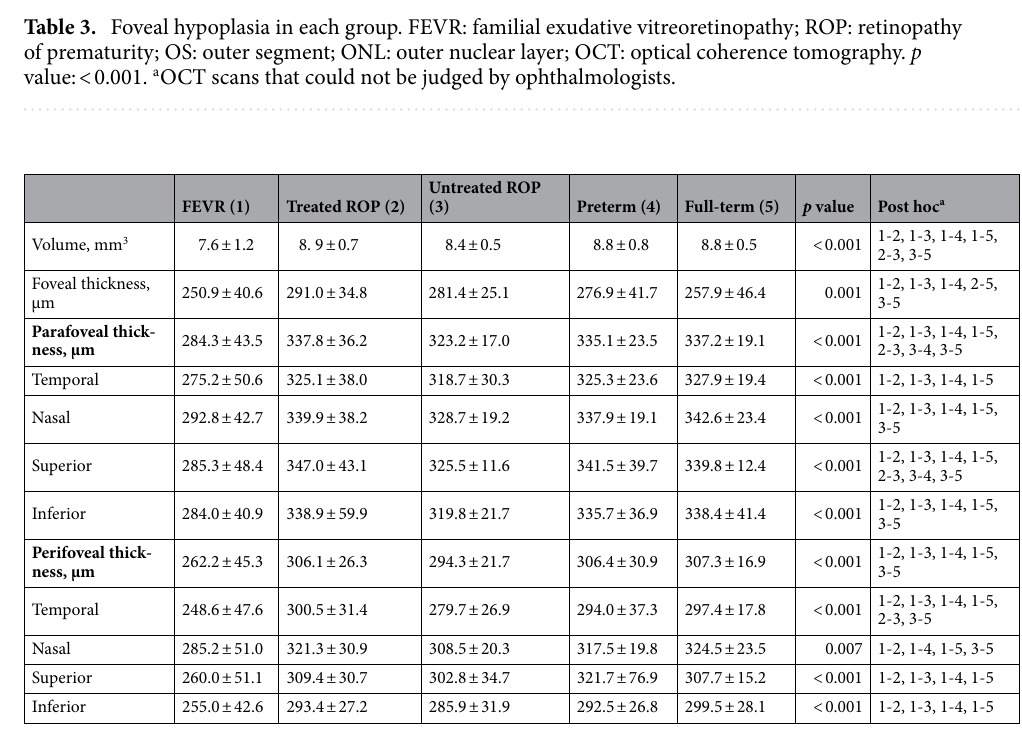
Table 4. Macular structures in each group. FEVR: familial exudative vitreoretinopathy; ROP: retinopathy of prematurity. a Intergroup comparisons were made using the post hoc comparisons from significant generalized estimating equations; the pairs of groups listed (e.g., 1-2) are significantly different. Pairs not shown are not significantly